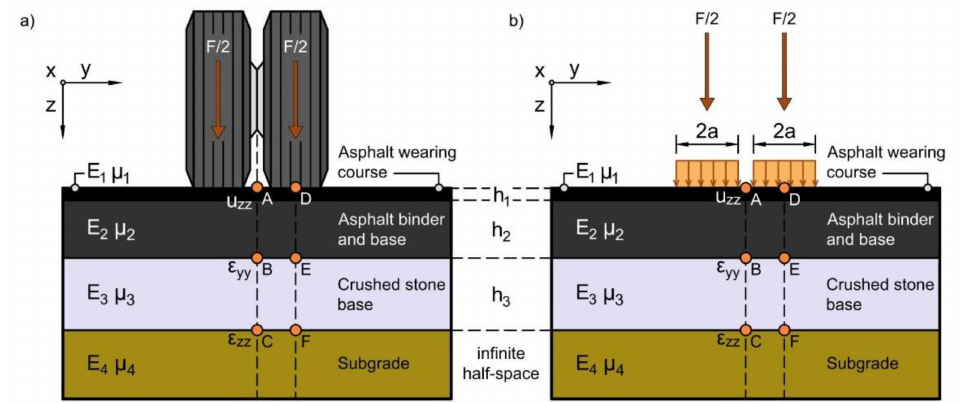
Figure 7. The realistic twin tyre loading ( a ) and the substituting circular plate model with equivalent contact area ( b